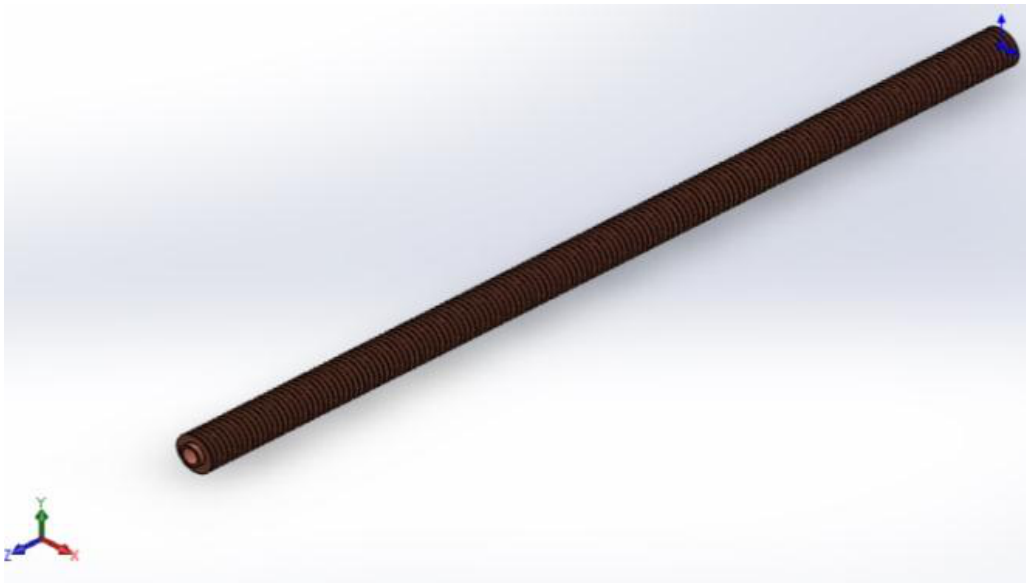
Figure 6. 3D model of the heat exchange